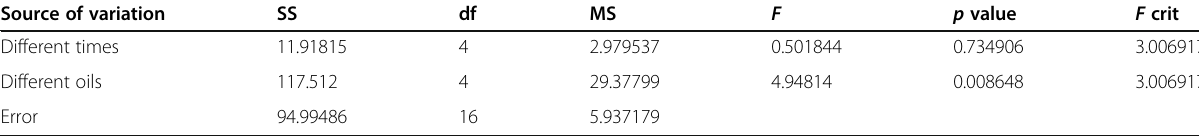
Table 3 Two-factor ANOVA analysis for lipase induction by different substrates at different time courses Source of variation SS df MS F p value F crit Different times 11.91815 4 2.979537 Different oils 117.512 4 Error 94.99486 16 5.937179 SS sum of squares, MS mean